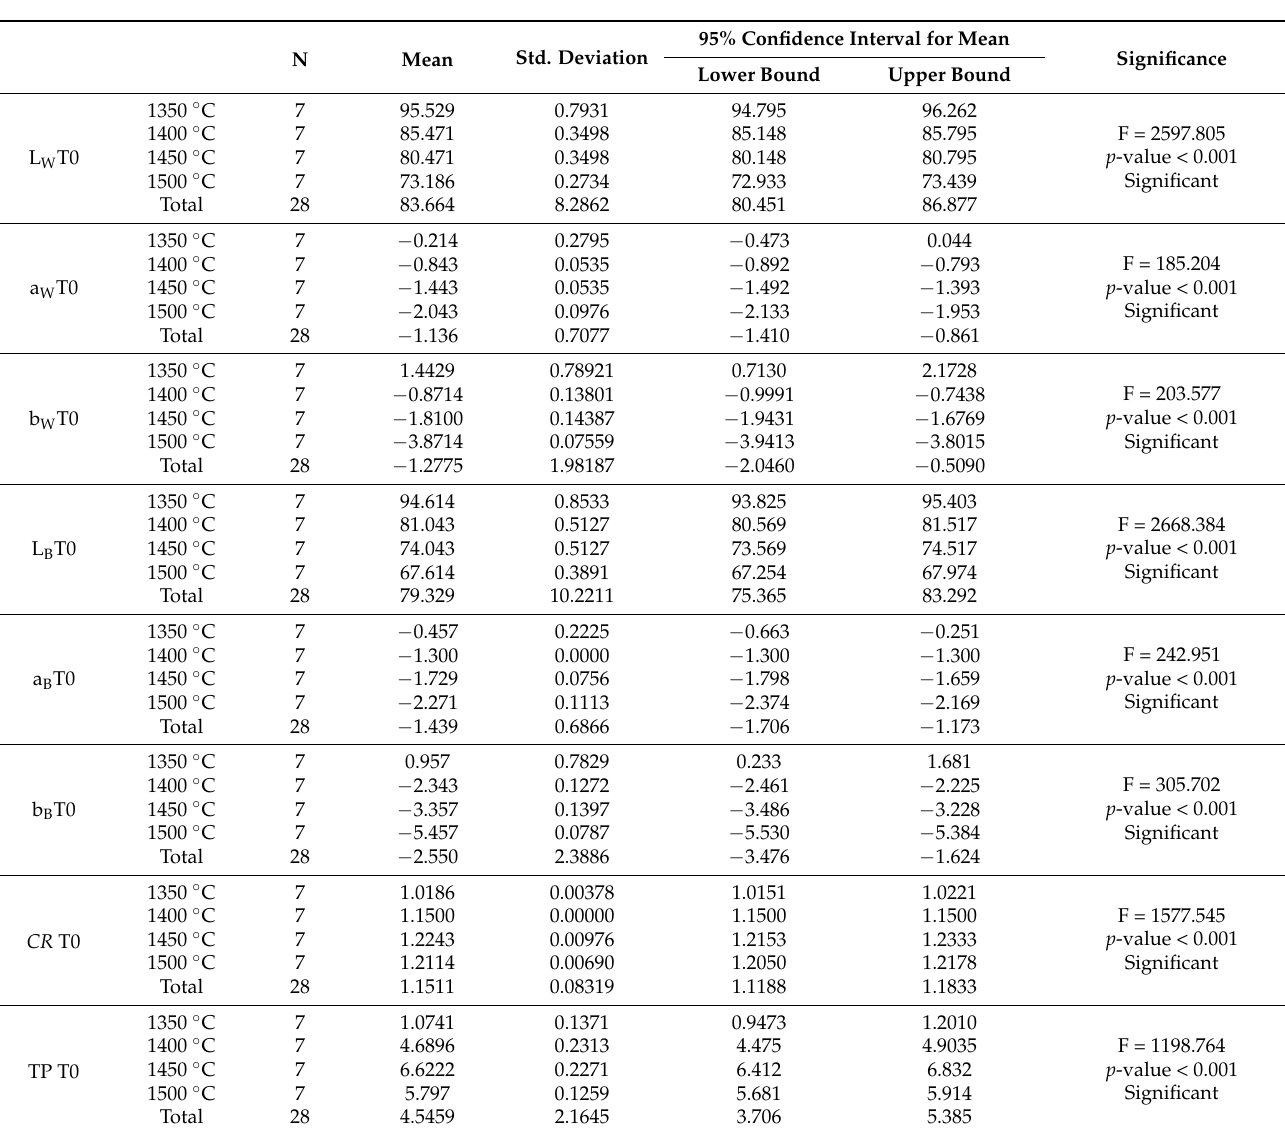
Table 2. Mean of color, translucency parameter (TP), contrast ratio ( CR ), and intergroup comparison between four groups before artificial